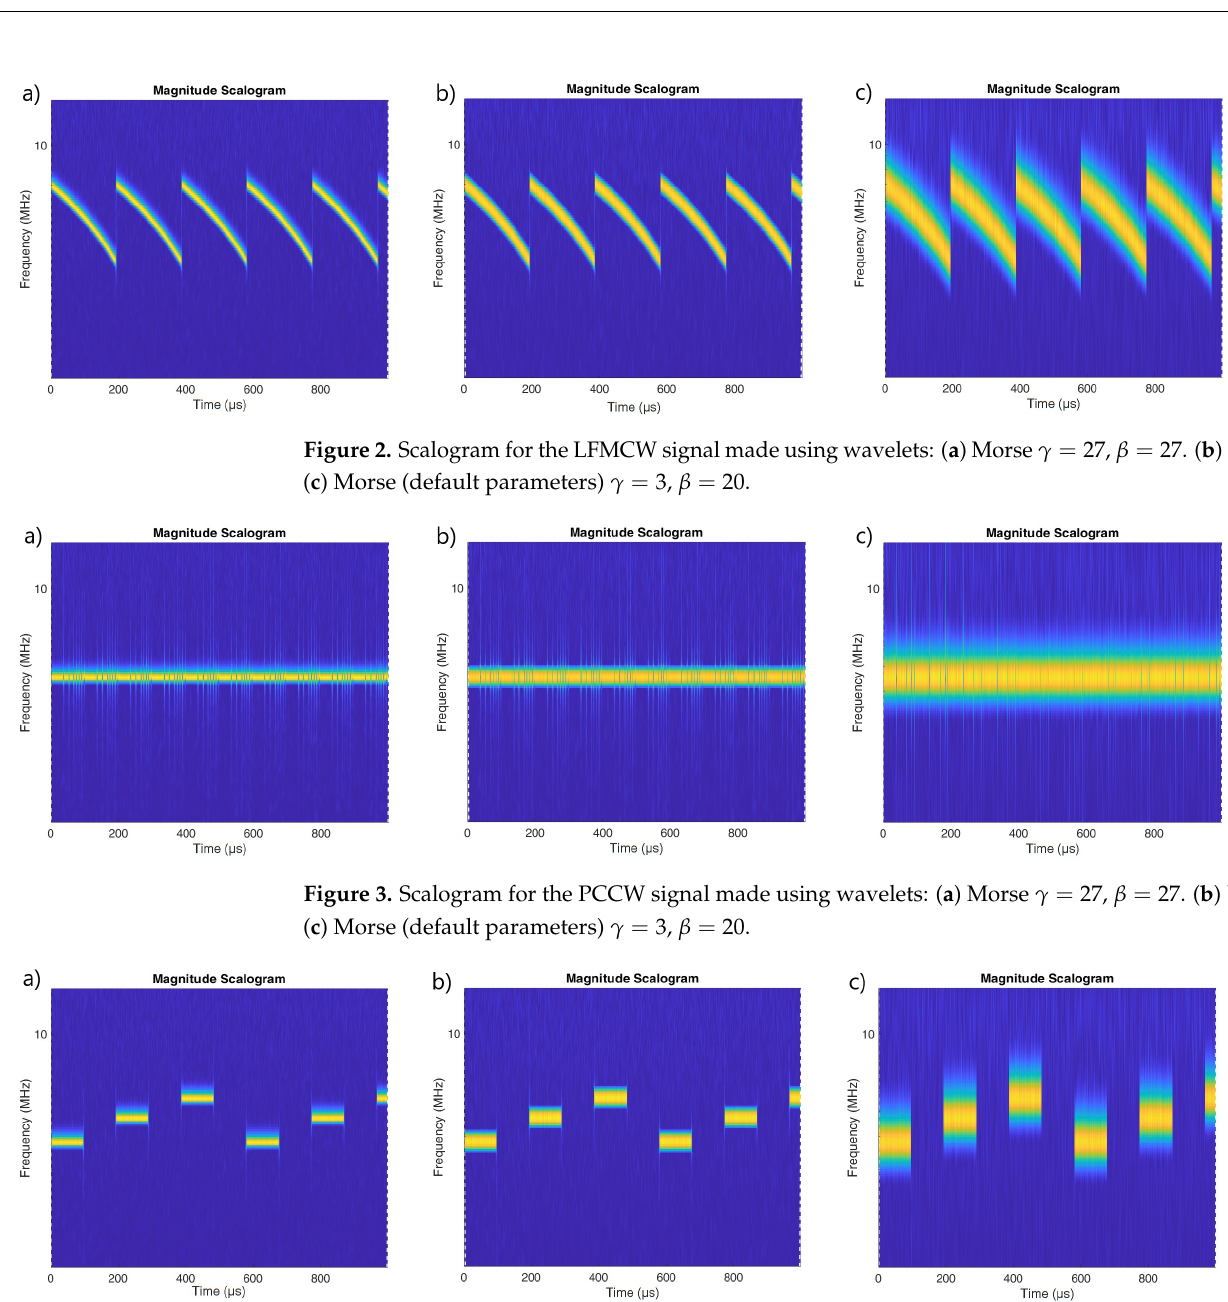
Figure 4. Scalogram for the SFM pulsed signal made using wavelets: ( a ) Morse γ = 27, β = 27. ( b ) Bump ( c ) Morse (default parameters) γ = 3, β =